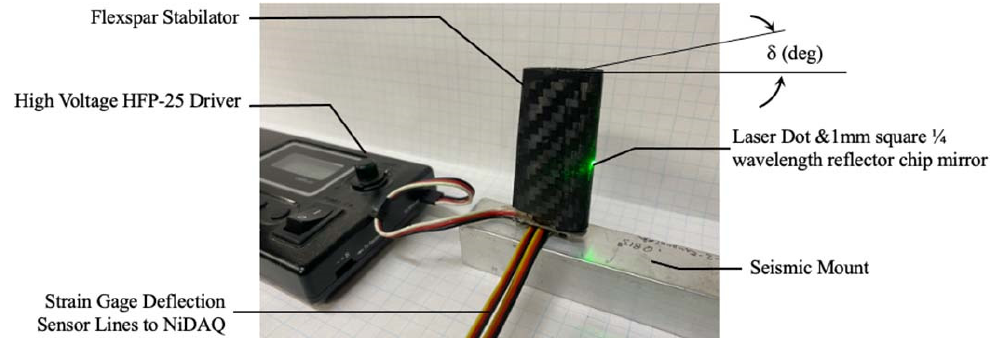
Figure 13. Test Setup with Laser Reflection Mirror and 1/4 ″ (6.35 mm) Quadrule.